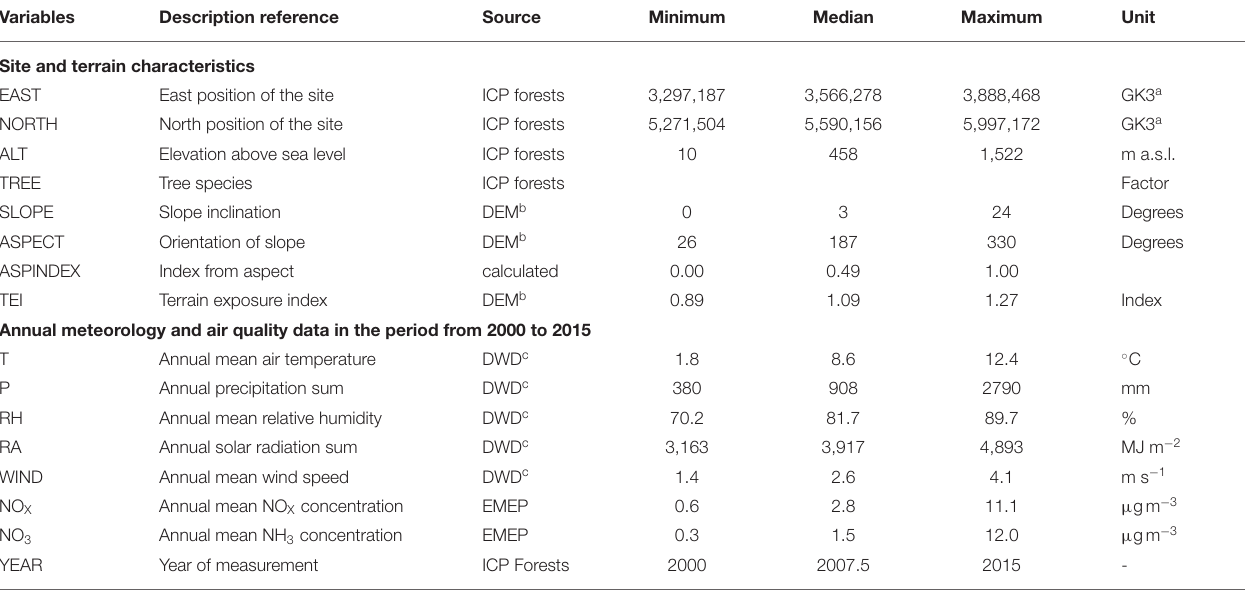
TABLE 4 | Summary of data sources for explanatory variables in the statistical models to analyze the differences in TIN deposition between the three approaches.